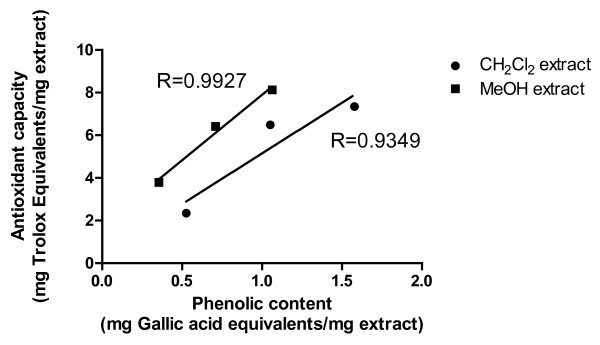
Correlation of antioxidant activity with phenolic contents. The relationship between total phenolic content in individual extract and their antioxidant capacity. The correlation analyses were described as linear correlation coefficient (R).